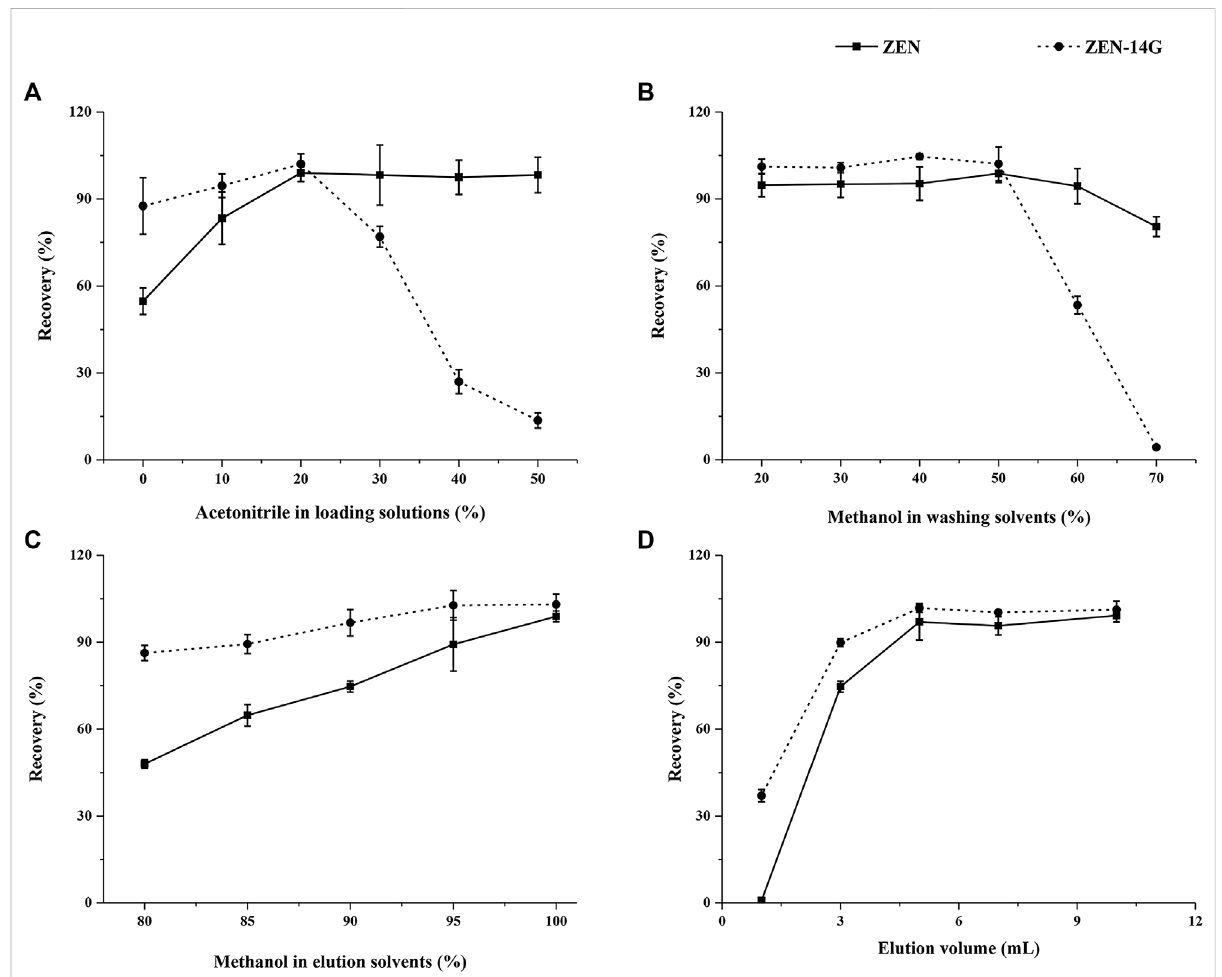
FIGURE 2 Optimization of the critical parameters on the performance of the HLB-SPE cartridges including the percentage of acetonitrile in sample loading solutions (A) , percentage of methanol in washing solvents (B) , percentage of methanol in elution solvents (C) , and elution volume (D) using blank formula feed samples spiked with 50 μ g kg − 1 for both analytes (n =